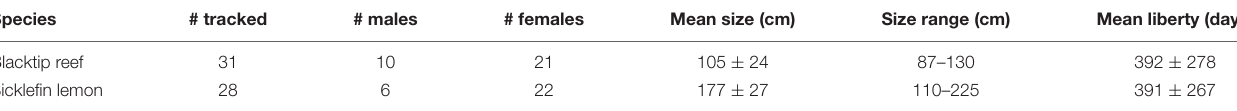
TABLE 1 | A summary of the tracked individuals used for analysis.